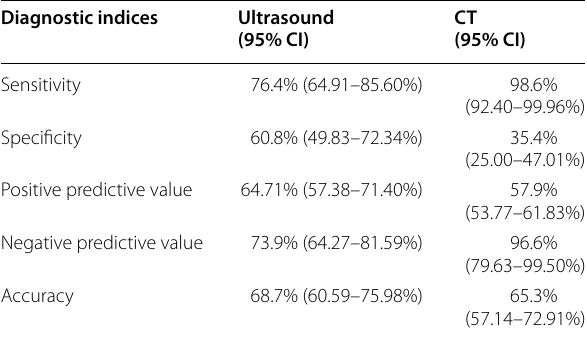
Table 7 Correlation between the lymph node diagnosis by CT